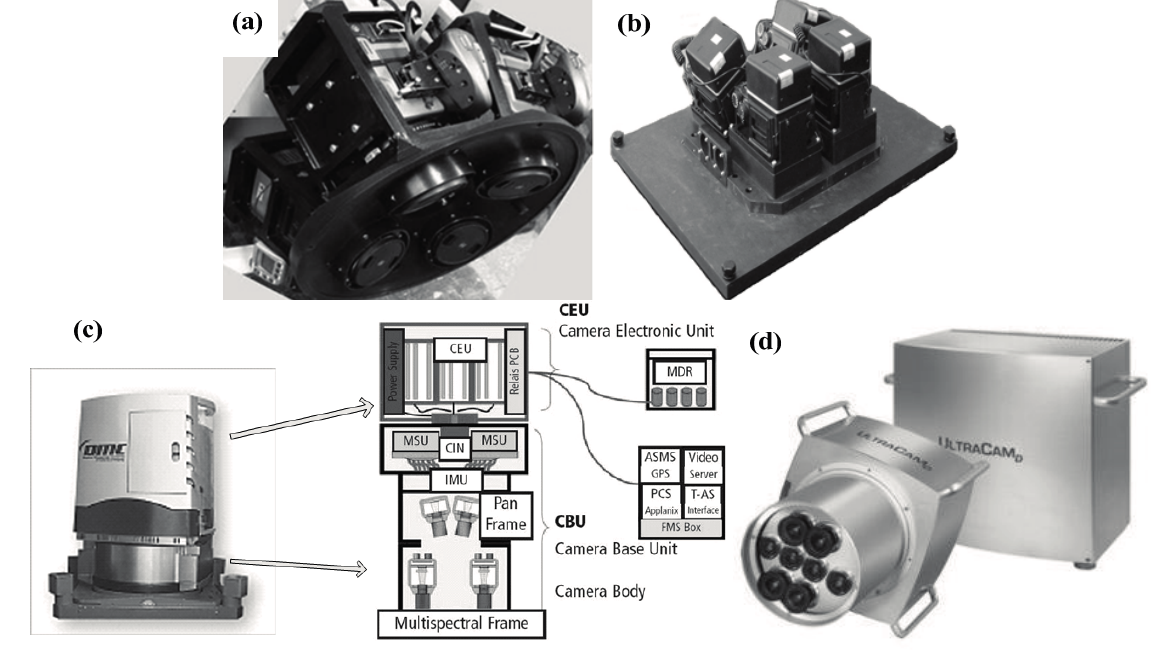
Figure 1. Exiting MDCSs: ( a ) SWDC-4; ( b ) MADC II; ( c ) DMC; and ( d )